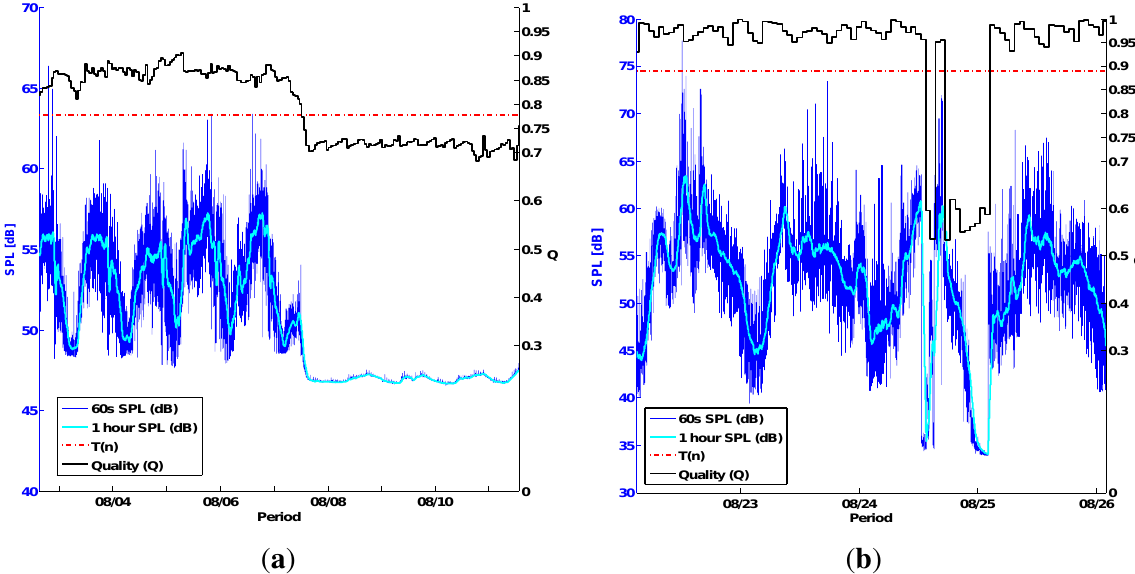
Two failure scenarios are shown here superimposed with the measured quality (Q). Q drops below the threshold T ( n ) immediately after a sensor failure, proving its capacity to detect a failure condition. ( a ) Sensor failure Test Node 2 and Q (MC); ( b ) Sensor failure Test Node 3 and Q (MK).